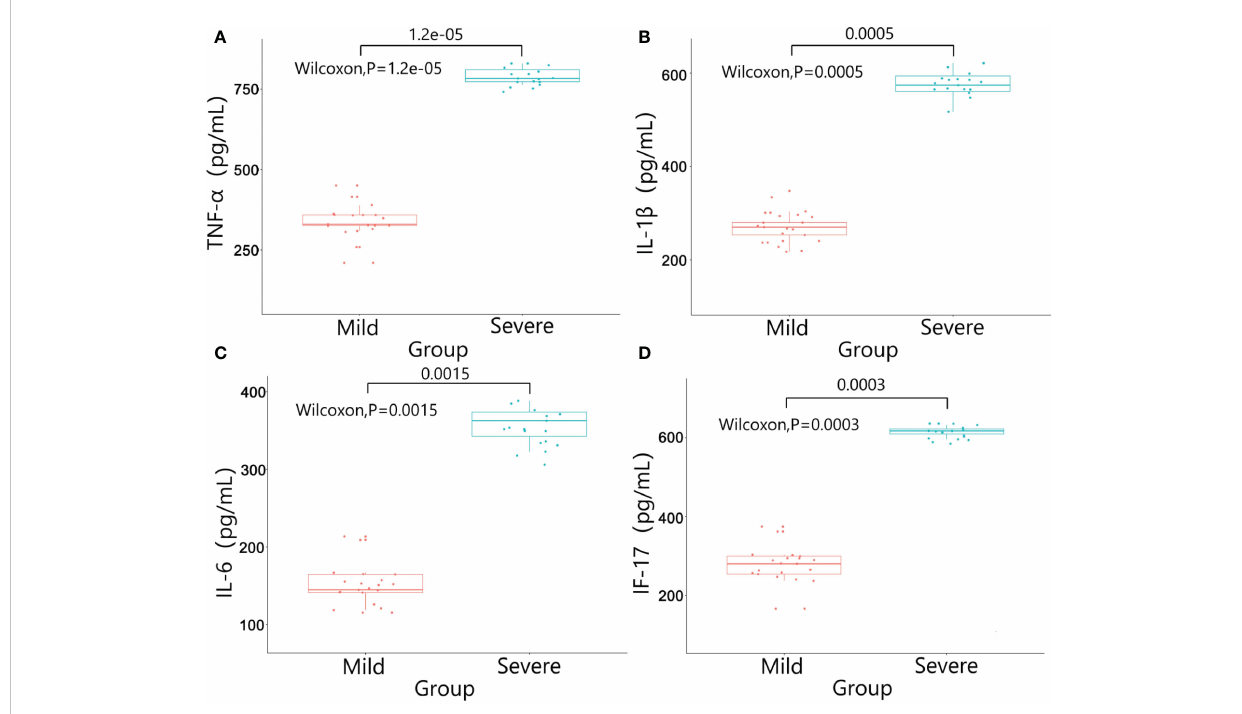
FIGURE 2 Results of in fl ammatory factors in colon wall tissue between the two groups. (A) TNF- a ; (B) IL-1 b ; (C) IL-6; (D)